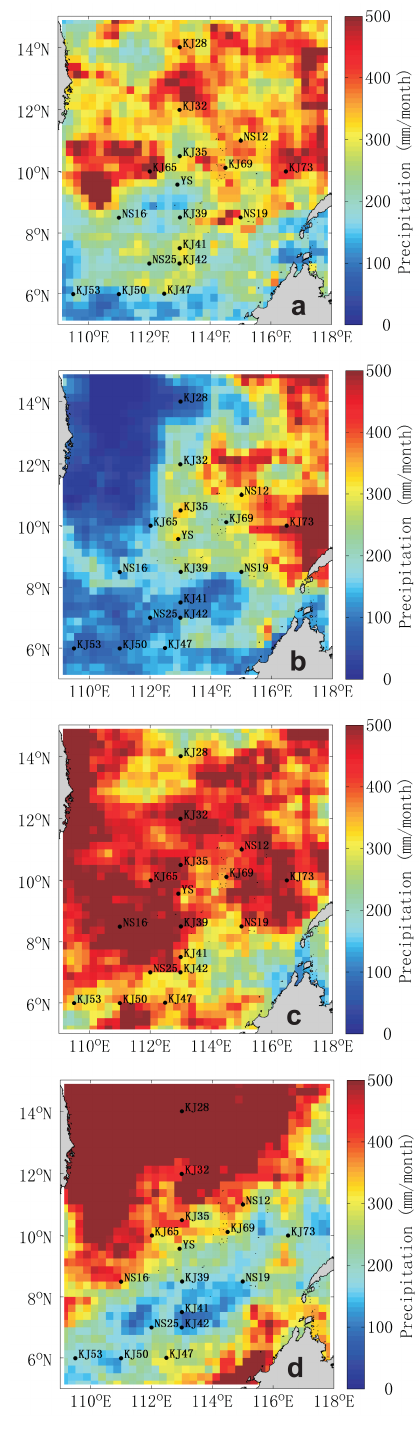
Figure 6. Monthly rainfall in the southern South China Sea es- timated on the basis of data from the Tropical Rainfall Measur- ing Mission. (a) May 2009; (b) June 2009; (c) October 2010; (d) November